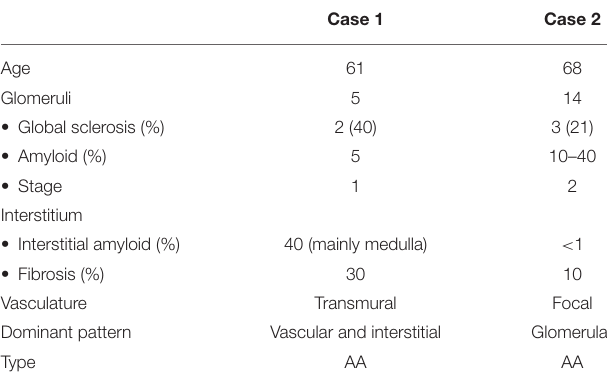
TABLE 1 | Histopathological analysis with scoring of amyloid deposition according to Hopfer et al.